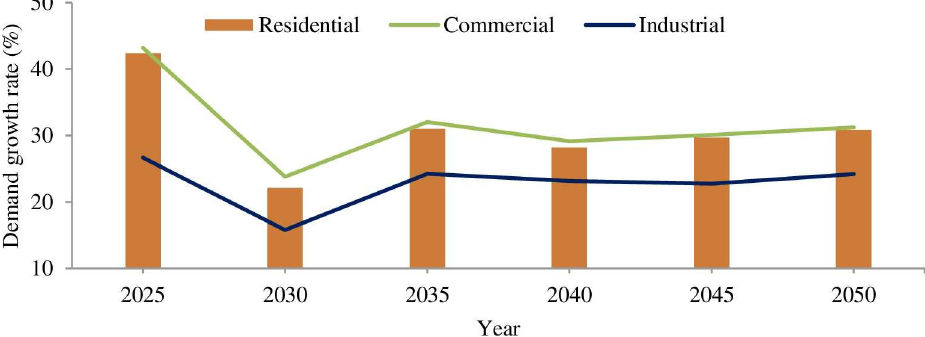
Fig 11. Estimated water demand growth in the sector. Residential sector has high water demand growth rate as compared to commercial and industrial sector. The demand growth rate for commercial, industrial and residential will be increases by 5%, 3.7% and 4.8% respectively annually from 2016 to